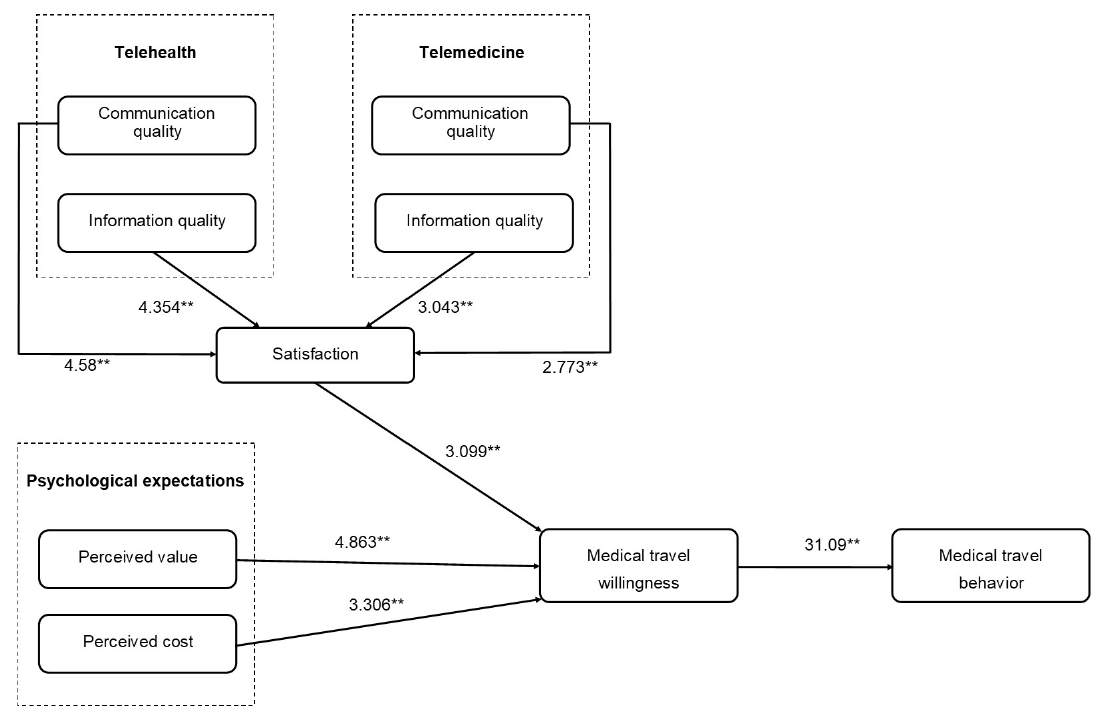
Figure 2. Model results. The t-values of the path coefficients are shown alongside each path. The double asterisks (**) represent p < 0.01. Table 6. Structural parameter estimates.